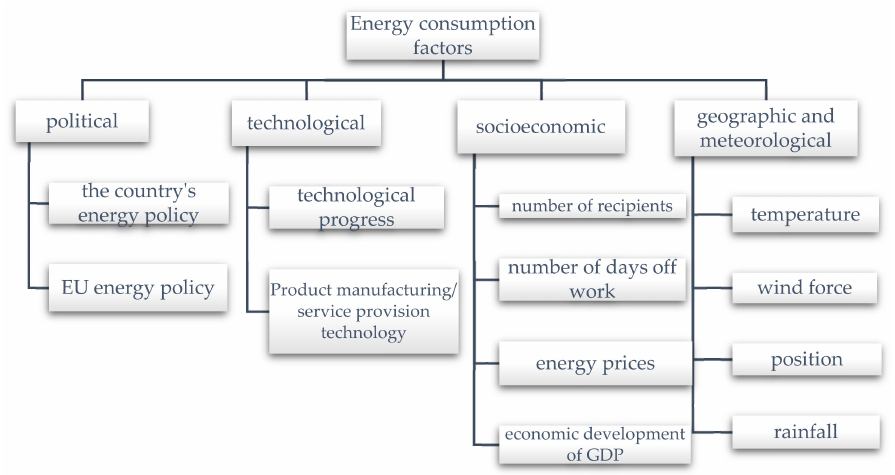
Figure 1. Factors influencing energy consumption in enterprises. Source: